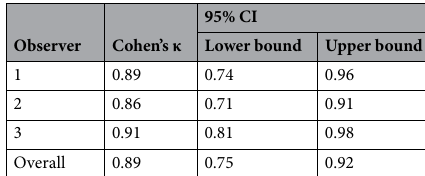
Table 3. Cohen’s κ for intra-observer reliability.